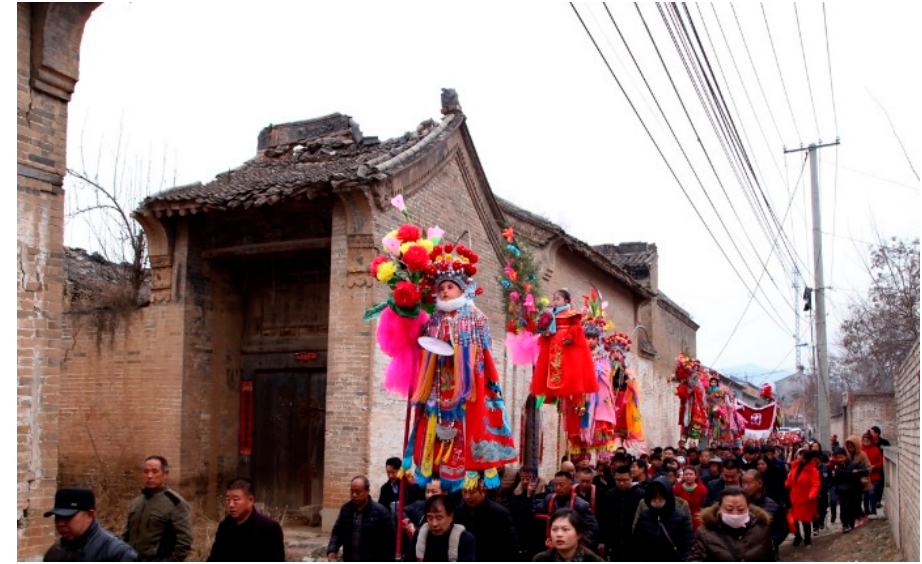
Figure 6 . The Kangzhuang parade during the Longtaitou Festival in Dongyi Village, March 2018 (© Lui Tam) .